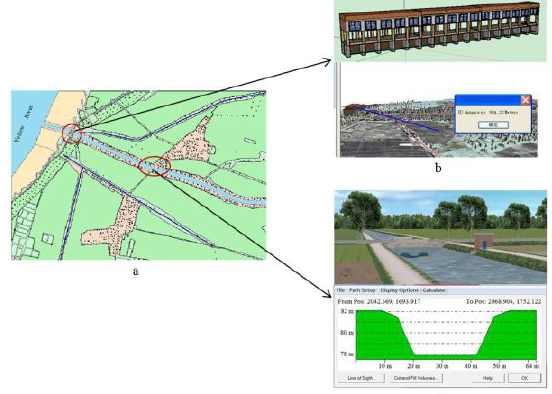
Fig.8 Comparison of ground features between 2D and 3D